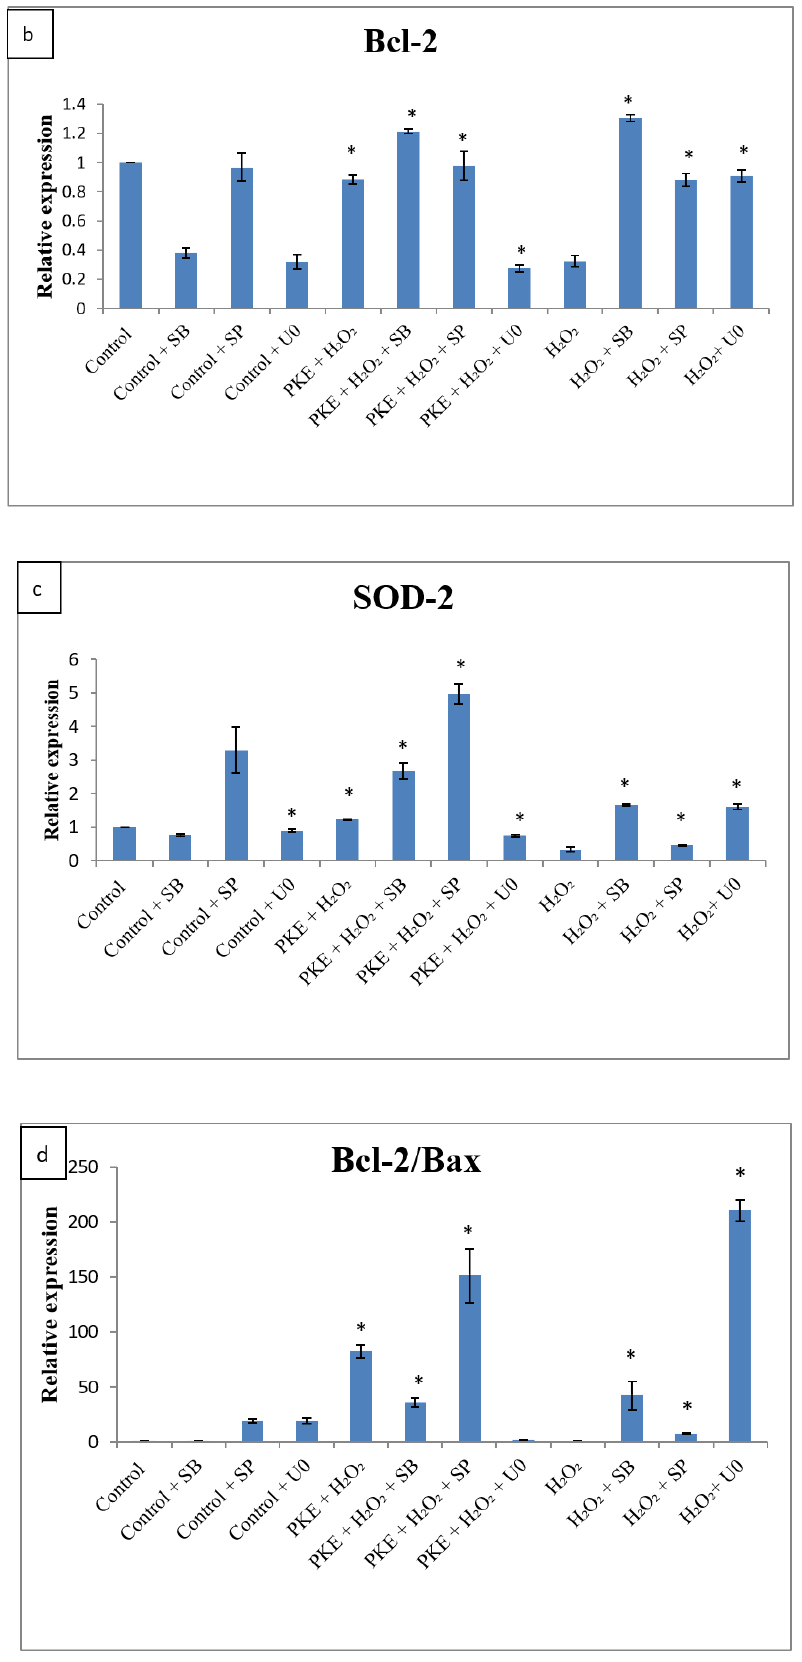
Figure 6. The gene expression of Bax ( a ), Bcl-2 ( b ), SOD-2 ( c ), and Bcl-2/Bax ( d ) after SW1353 was treated with MAPK inhibitors with added PKE or H 2 O 2 . Values are expressed as mean ± SD ( n = 3), * p < 0.05 for compared with control